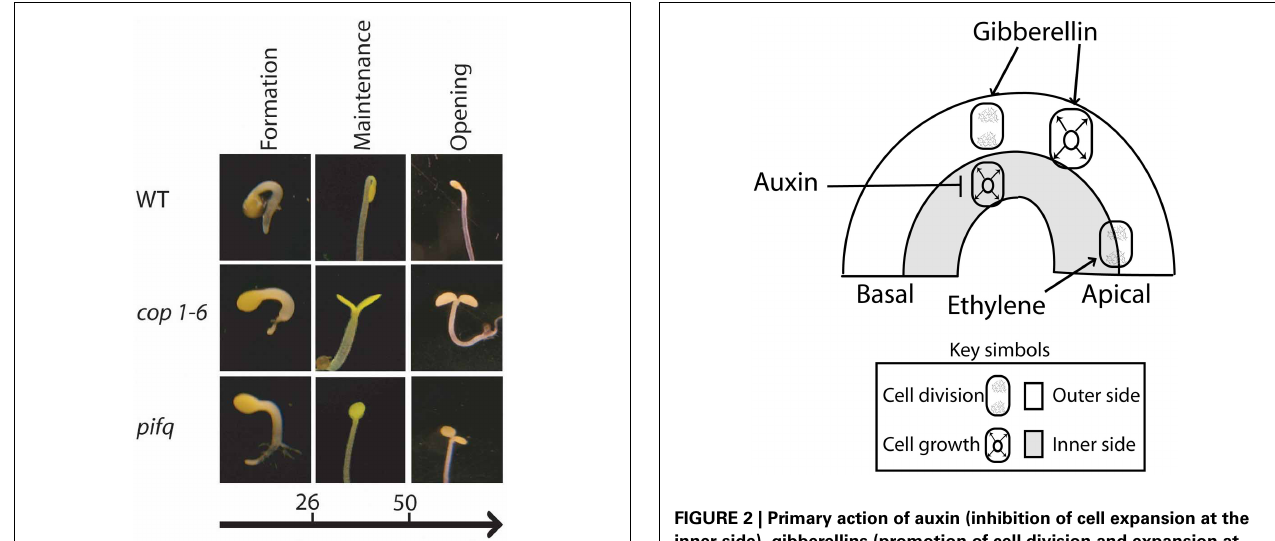
FIGURE 2 | Primary action of auxin (inhibition of cell expansion at the inner side), gibberellins (promotion of cell division and expansion at the outer side) and ethylene (enhanced cell division at the top) during apical hook development. There are interactions not represented here, such as the effects of gibberellins and ethylene on the auxin signaling gradient (see Figure 3 ). Auxin inhibition of cell growth at the inner side of the hook might be mediated by an enhanced ethylene signaling as auxin levels concentrations above a threshold might enhanced ethylene production and signaling contributing to cell growth inhibition (Abel et al., 1995; Raz and Ecker, 1999; Vandenbussche et al., 2010). Arrows: